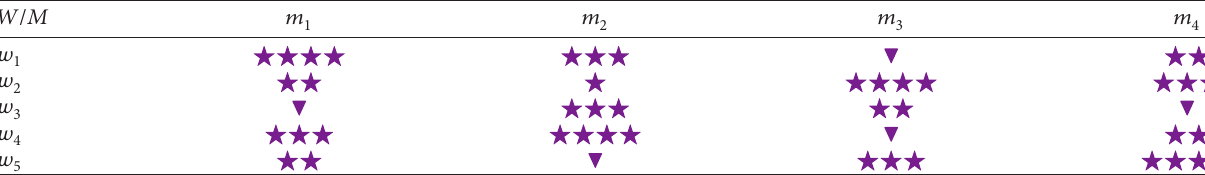
Table 2: Ranking of spillways.